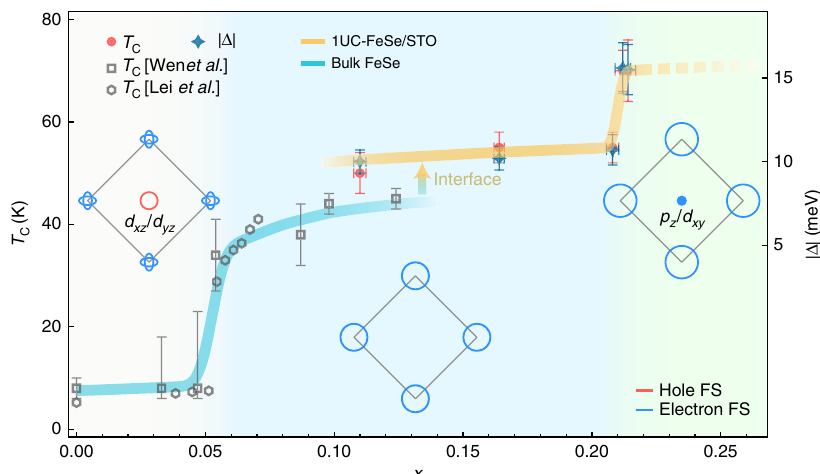
Figure 4 | Schematic phase diagram of FeSe. The phase diagram illustrates the evolution of superconductivity and the FS topology. The data at x ¼ 0.11 is from our previous study 24 . The T c data of bulk FeSe, as traced with a cyan curve, is adapted from refs 13,15. The error bars of the superconducting gap include s.d. of the fitting. The error bars of T c include the measurement uncertainties. We caution that the dashed line is a possible extrapolation result that do not take into account the possible instability of the material for dopings higher than x ¼